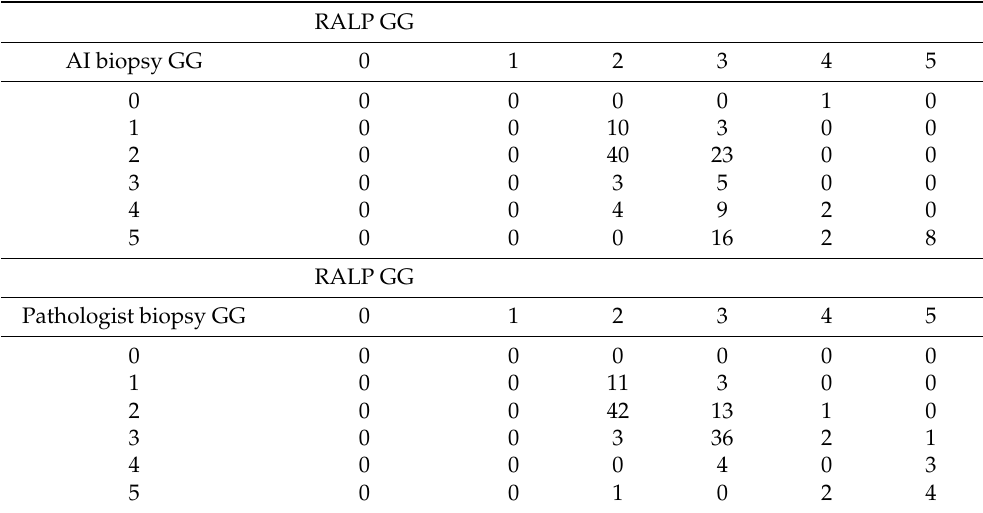
Table 8. Cross tabulation showing down- and upgrading of the biopsy session GG in the RALP